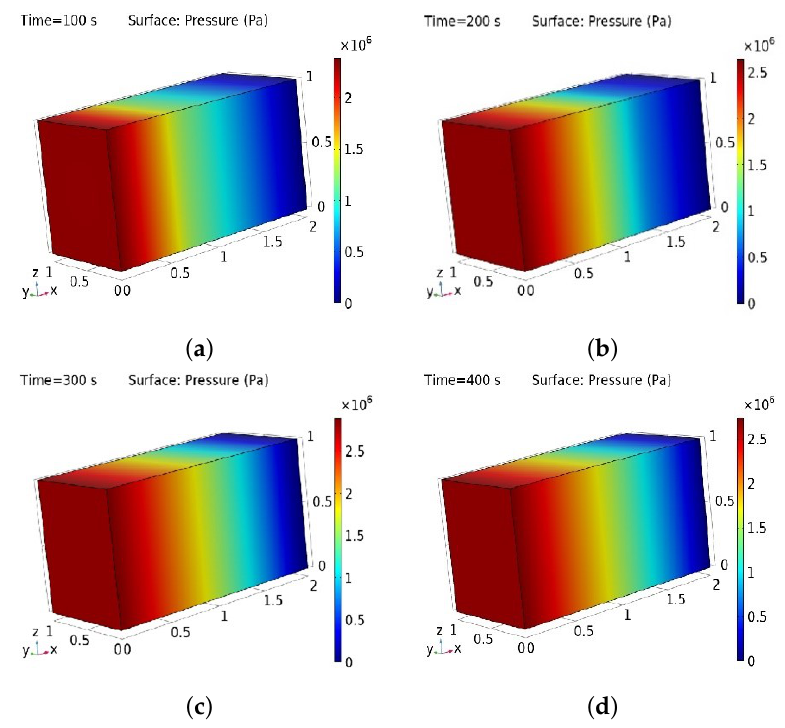
Figure 12. Pressure at ( a ) 100 s, ( b ) 200 s, ( c ) 300 s, and ( d ) 400